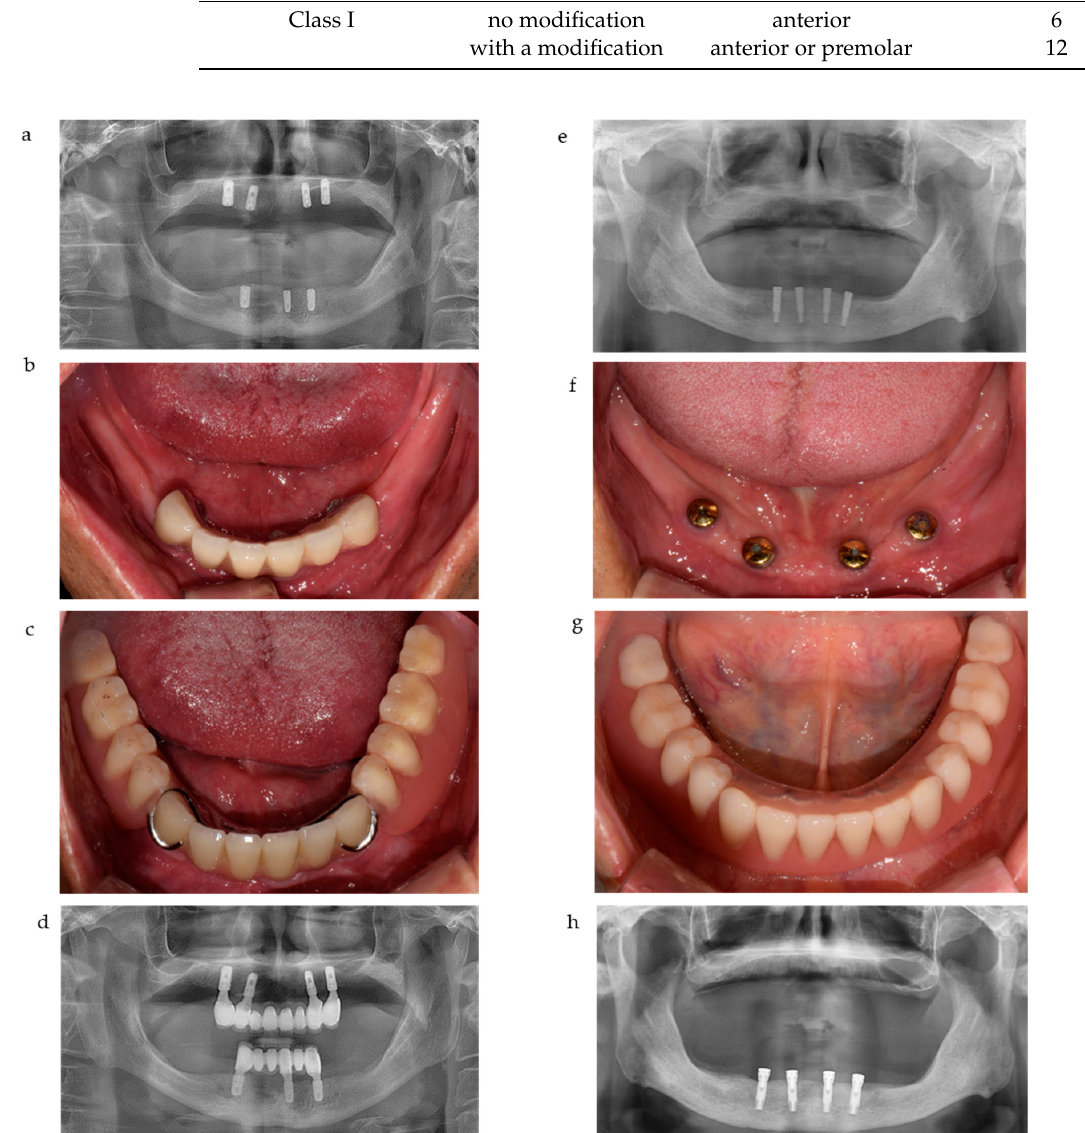
Figure 1. The representative cases of IC-RPD and IOD in this study. (a ) Implants were placed in anterior positions due to anatomical limitations. (b) Intraoral view of IC-RPD case. (c) Delivery of IC-RPD. (d) Panoramic radiograph of IC-RPD case. (e) Four implants were placed in anterior positions due to anatomical limitations. (f) Intraoral view of IOD case. (g) Delivery of IOD. (h) Panoramic radiograph of IOD case.